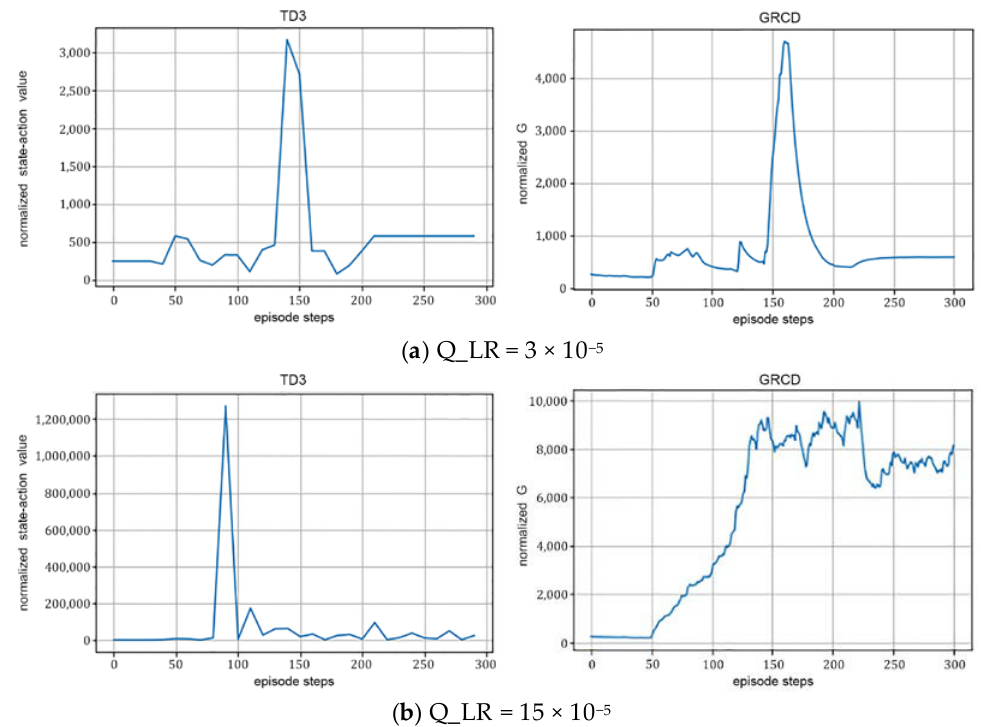
Figure 8. Effect of different learning rates on algorithm performance; N = 36, Explore_steps = 5000, γ = 0.99, and Hidden_dim =